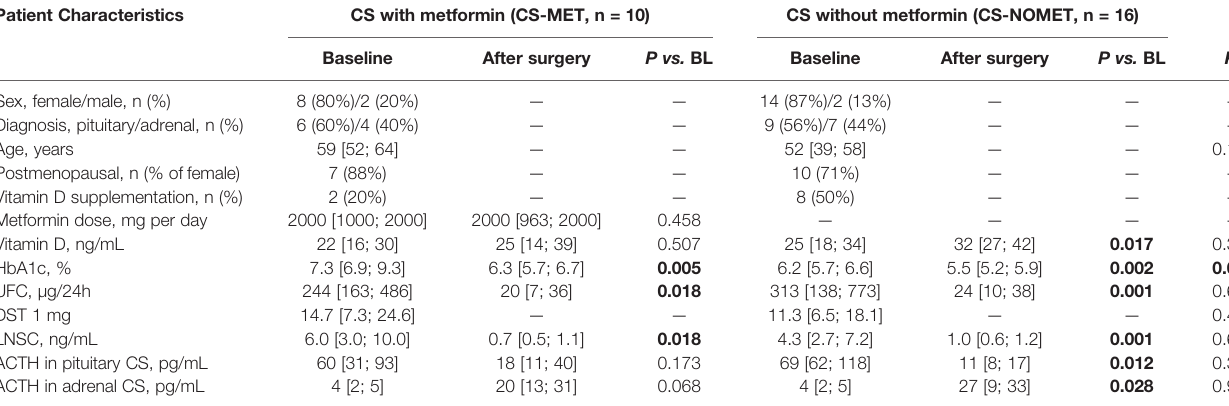
TABLE 1 | Baseline and 1-year follow-up characteristics of patients with CS ±